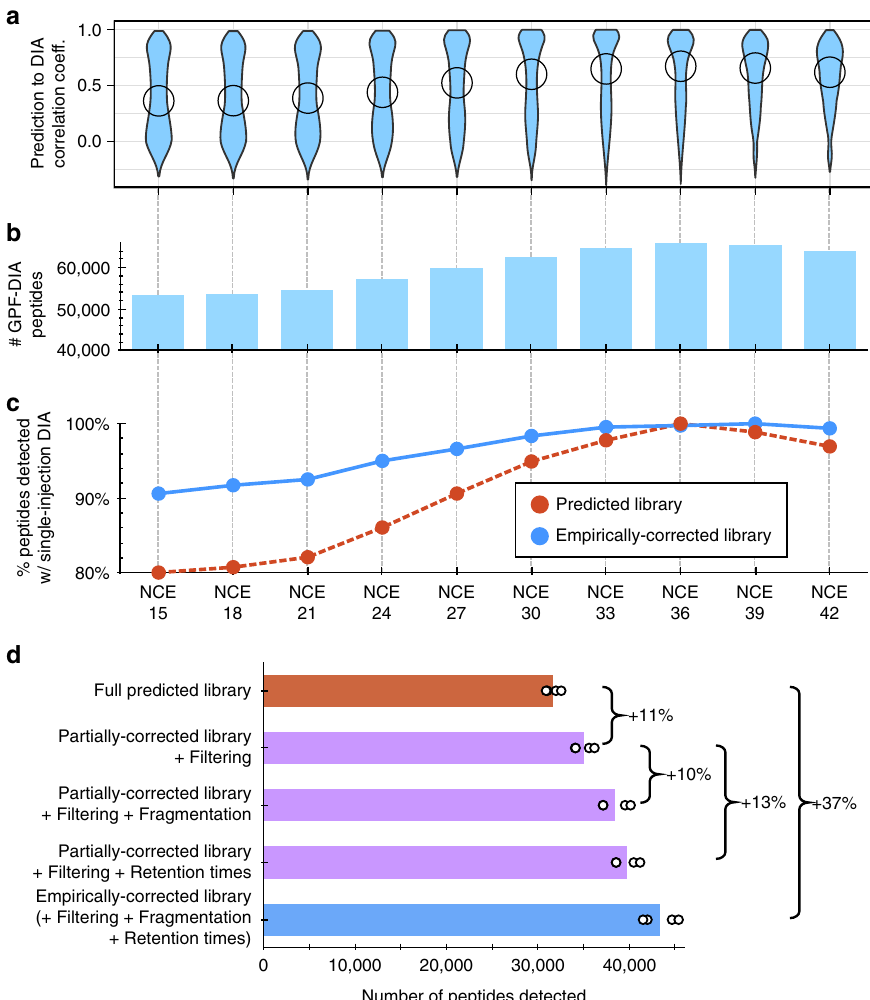
Fig. 2 Evaluating empirically corrected libraries made with peptide predictions. a Violin plots showing spectral correlation between predicted library for yeast peptides and single-injection DIA ( N = 1) at various NCE settings (circles indicate medians) when the instrument was con fi gured for NCE = 33. b The total numbers of empirically corrected library entries detected from GPF-DIA at various NCE settings ( N = 1). c The fraction of peptides detected in single- injection DIA ( N = 1) relative to the optimal NCE for empirically corrected libraries (blue line) are more consistent than predicted libraries (red dashed line) across a wide range of NCE settings. d The number of yeast peptides detected at 1% peptide FDR in single-injection DIA acquisitions ( N = 4) using the NCE = 33 chromatogram library, where either the retention times or fragmentation patterns have been switched with the predicted Prosit values (purple bars). Compared to the predicted spectrum library search (red bar), an 11% increase comes from simply using a narrowed peptide selection. DIA-based retention times and fragmentation patterns provide a 13% and 10% increase over this, respectively. Comparing the empirically corrected library and the predicted library detections (blue bar, 37% increase), these percentage gains appear to be nearly multiplicative (i.e., 111% × 110% × 113% = 138%), indicating that all three factors are independent and of roughly equal importance. Source data are provided as a Source Data fi